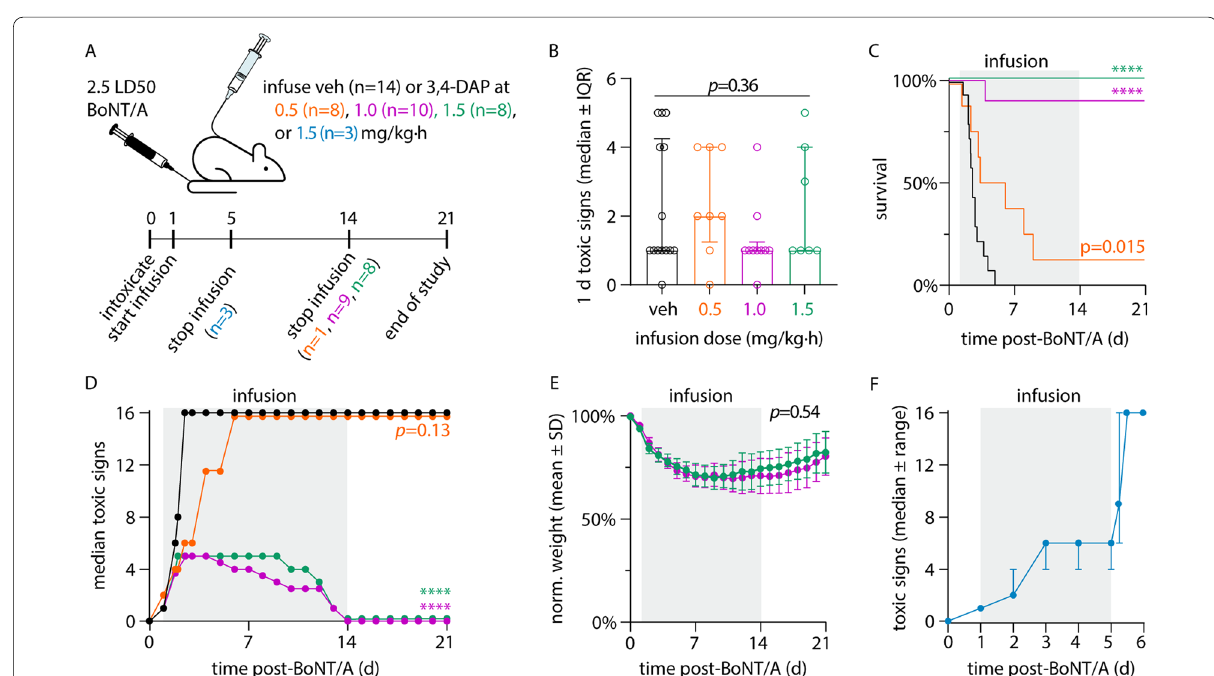
Fig. 3 Continuous infusion of 3,4‑DAP has both symptomatic and antidotal effects in lethally intoxicated rats. Catheterized rats were intoxicated by intravenous injection of 2.5 LD 50 BoNT/A. At 27 h after intoxication, continuous infusion was started with saline vehicle (n 14) or 3,4‑DAP at = 0.5 mg/kg∙h (n 8), 1.0 mg/kg∙h (n 10) or 1.5 mg/kg∙h (n 8). Toxic signs, weight and survival were monitored at 6–24 h intervals. Colors are = = = consistent among panels A‑E. Gray boxes represent infusion period. A Summary of experimental strategy. B Toxic signs at start of infusion. Data are presented as median IQR. C Kaplan–Meier survival curves for each treatment group. D Median toxic signs for each group over time. For panels C ± and D , significance indicators show pairwise comparisons made to vehicle. E Mean SD normalized body weights for survivors in 1.0 mg/kg∙h and ± 1.5 mg/kg∙h treatment groups. F Median IQR toxic signs for rats (n 3) infused from 1 to 5 d with 1.5 mg/kg∙h 3,4‑DAP. Treatment was withdrawn ± = at 5 d and toxic signs were monitored at 6 h intervals. **** p < 0.0001, * p <